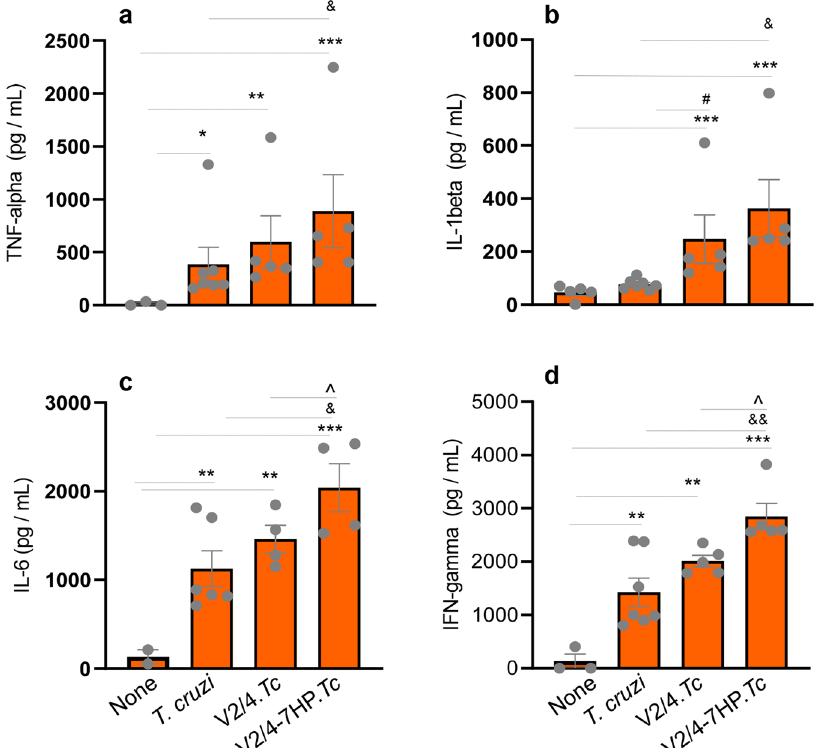
Fig. 5 Cytokine release by splenocytes of T. cruzi infected mice immunized with the vaccine (±7HP349). C57BL/6 female mice were immunized, challenged, and euthanized as in Fig.2c. Splenocytes were incubated for 48 h with T. cruzi antigenic lysate. An ELISA was performed to measure the TNF- α ( a ), IL-1 β ( b ), IL-6 ( c ), and IFN- γ ( d ) cytokines release in the supernatants. Data are derived from n = 5 – 10 mice per group (at least duplicate observations per sample) and plotted as mean values ± SEM. Signi fi cance between control vs. infected mice (*) was calculated by unpaired t -test or Mann – Whitney U test. Signi fi cance among infected groups was calculated by 1-way analysis of variance (ANOVA) with Tukey ’ s post-hoc test (comparison of multiple groups) and plotted as # infected vs. V2/4. Tc , ^infected vs. V2/4-7HP349. Tc , and & V2/4-7HP349 vs. V2/4. P values of <0.05, <0.01, and <0.001 are annotated with one, two, and three symbols, respectively. The horizontal bar indicates the compared